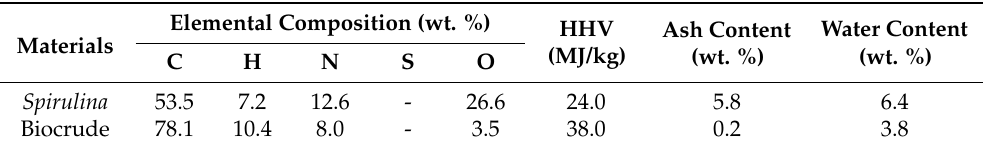
Table 1. Spirulina feedstock and HTL biocrude analysis. Elemental composition is expressed on dry basis and oxygen by difference.